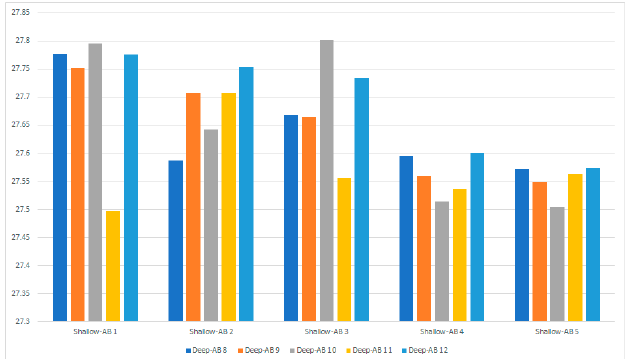
Figure 13. Results the number of Attention Blocks.